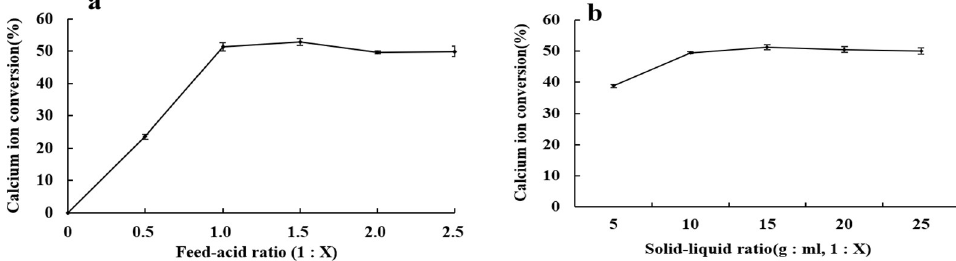
Fig 2. Effect of acid and liquid addition on the efficiency of free calcium extraction from bovine